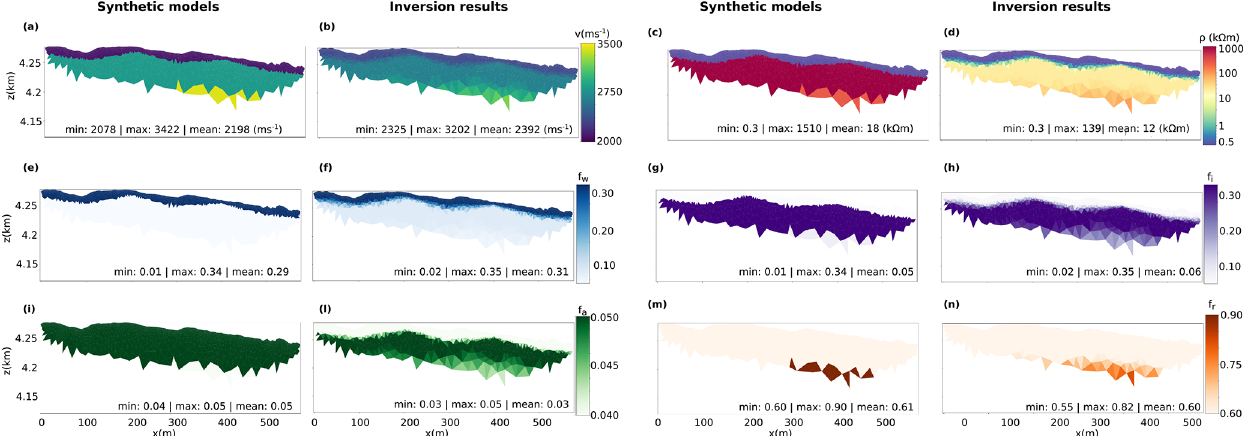
Figure A2. Synthetic models and results of petrophysical joint inversion for the El Ternero field data settings. (a, b) Velocity- and (c, d) resistivity-transformed models. The directly modelled and inverted parameters are (e, f) water, (g, h) ice, (i, l) air and (m, n) rock volumetric content. All models are cut off below the lowermost ray path, with only the resistivity colour bar expressed in logarithmic